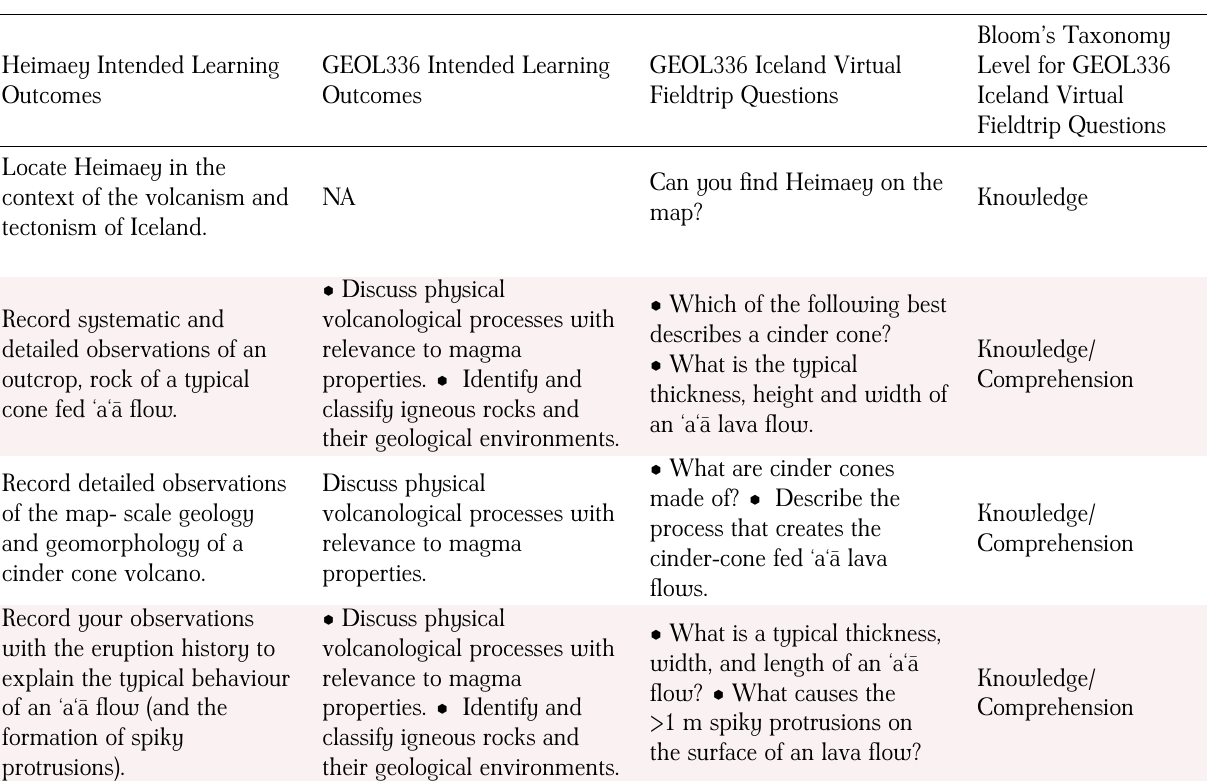
Table A2: Alignment of the VTF Heimaey intended learning outcomes, the intended learning outcomes from the third-year un- dergraduate volcanology and magmatic systems course, and the associated Bloom’s taxonomy